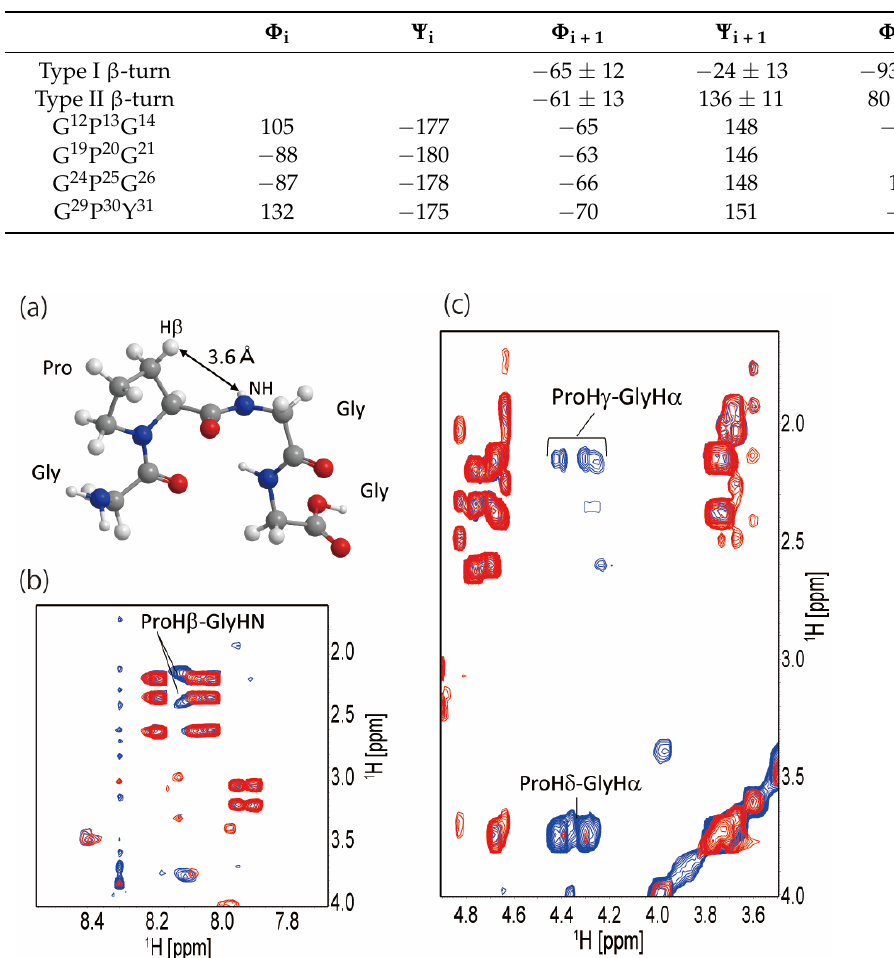
Figure 4. ( a ) Structural model of Gly-Pro-Gly-Gly motif formed typical type II β-turn structure; ( b ) superimposed spectra of 1 H- 1 H NOESY (blue) and 1 H- 1 H TOCSY (red) for RSP dissolved in FA. The NOESY cross-peaks between ProHβ and GlyHN whose distance is 3.6 Å illustrated in ( a ) are denoted. ( c ) Superimposed spectra of 1 H- 1 H NOESY (blue) and 1 H- 1 H TOCSY (red) for RSP dissolved in FA. The NOESY cross-peaks between GlyHα-ProHδ and GlyHα-ProHγ are denoted. Jenkins et al. reported 2D homo- and heteronuclear MAS solid-state NMR studies of the Gly-Pro-Gly-X-X motif in 13 C/ 15 N-Pro labeled A. aurantia dragline silk [61]. The data showed a secondary structure for the Pro residue in the motif similar to that